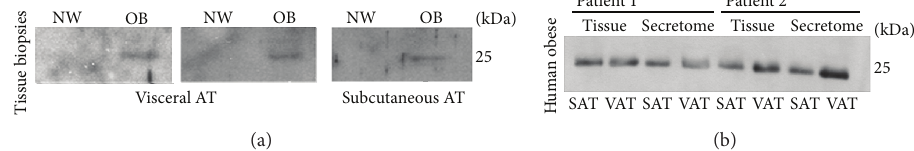
Figure 4: FNDC5/irisin detection on human adipose tissue. Representative immunoblot detection of FNDC5/irisin in human visceral adipose tissue (VAT) and subcutaneous adipose tissue (SAT) biopsies from NW and OB subjects (a); FNDC5/irisin immunodetection in human SAT and VAT biopsies and their secretome from OB individuals